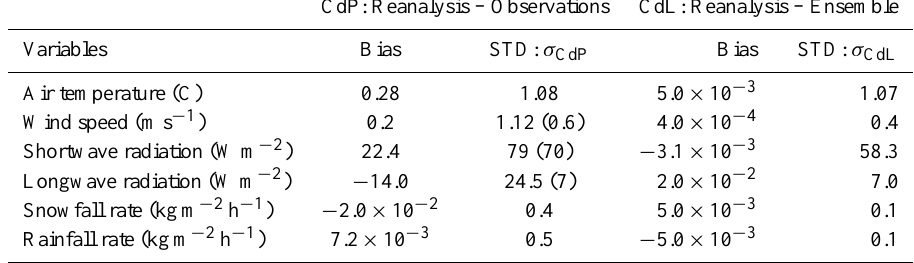
Table 1. Bias and standard deviations (STDs) of the differences between SAFRAN reanalysis and in situ observations (left) and the differ- ences between SAFRAN reanalysis and the ensemble built up in the present study (right), for the perturbed meteorological forcings. The first set of statistics is derived from 18 years (1993–2011) of observations and reanalysis at the CdP and the second set is derived from our 300-members ensemble over the 2010/2011 hydrological season. The values in brackets correspond to the adjusted standard deviation used to generate the ensemble at CdL